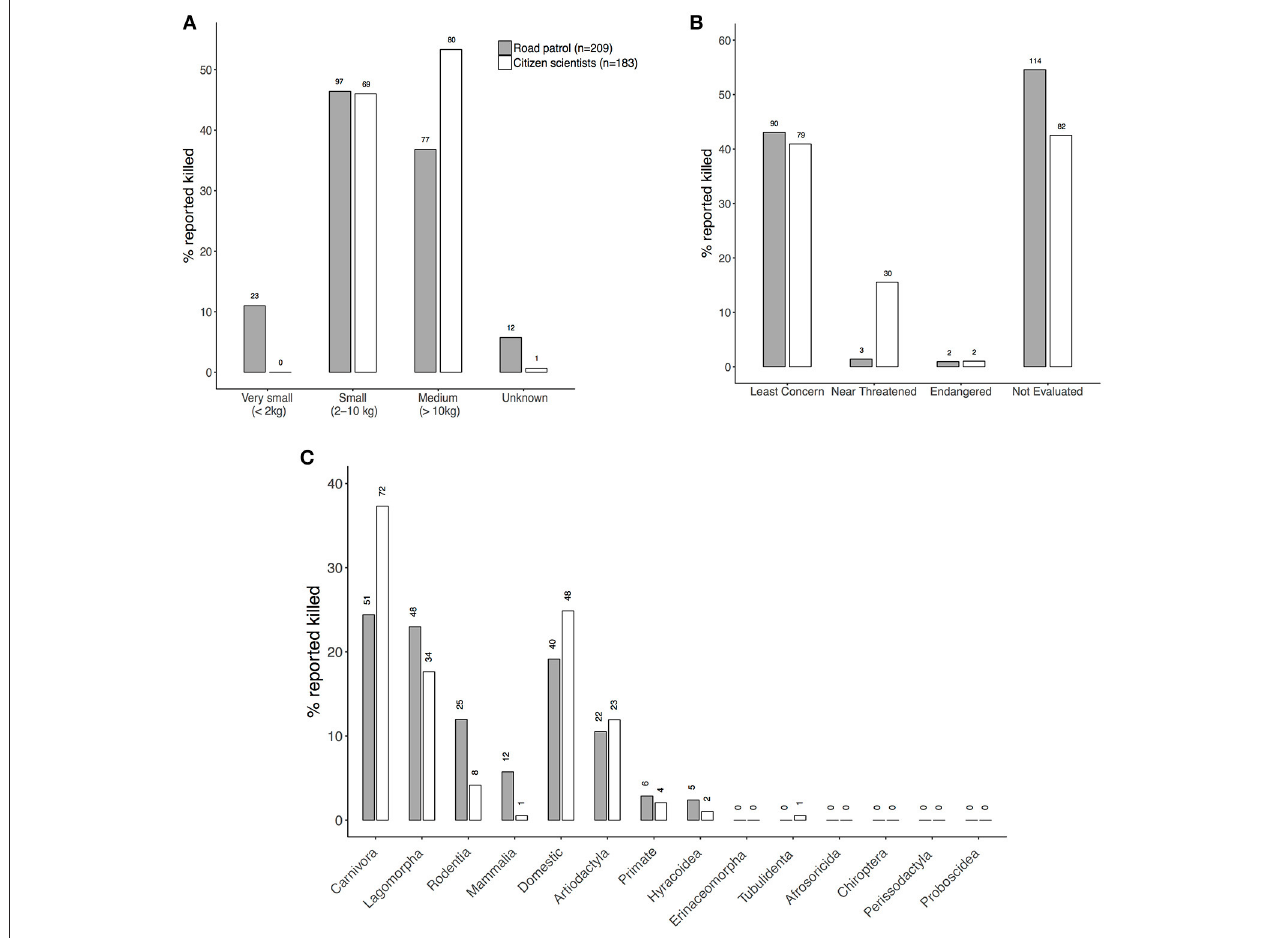
FIGURE 2 | Comparison of the distributions of (A) sizes, (B) Red List category of species and (C) taxonomic groups reported killed along a 431km section of the N3 road by road patrols (white) and citizen scientists (gray). Figures above bars represent the number reported in each category.